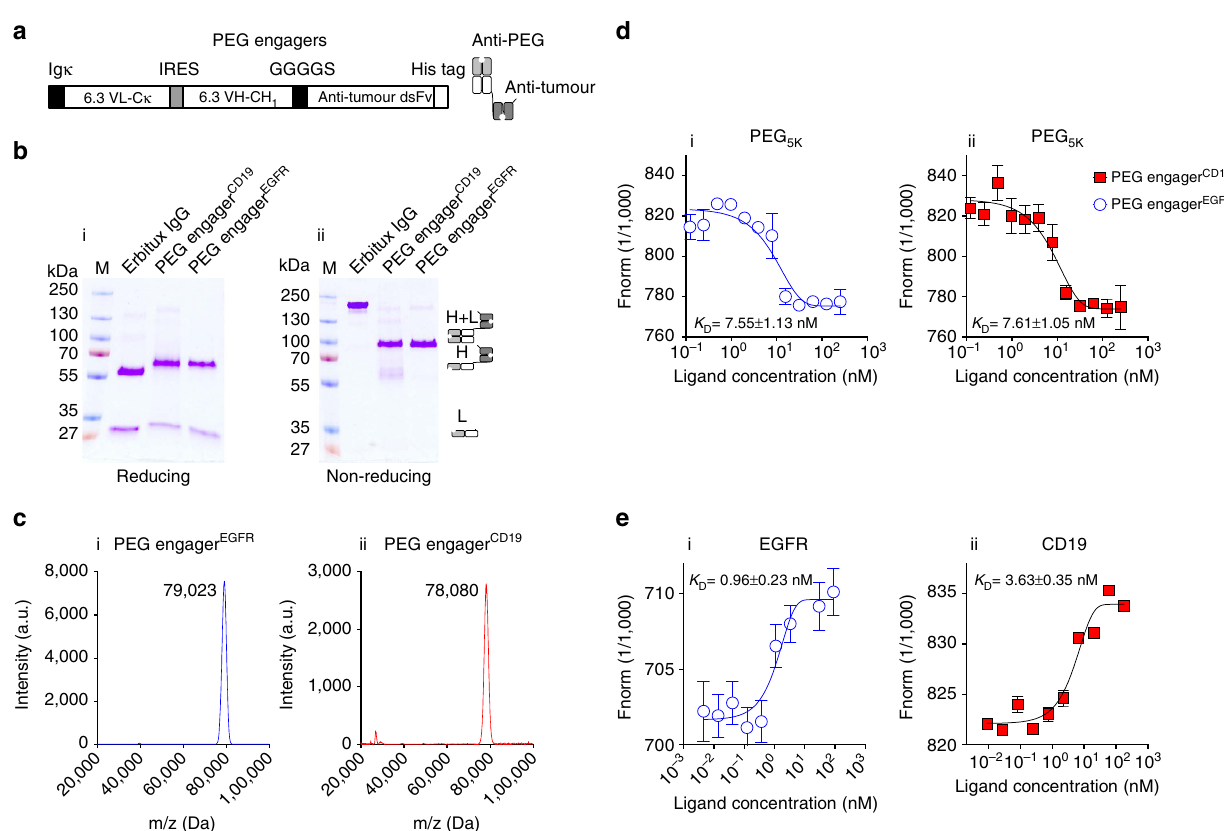
Figure 2 | Production and analysis of recombinant PEG engagers. ( a ) Schematic representation of PEG engager constructs, which code for a murine immunoglobulin kappa chain leader sequence (Ig k ), a humanized 6.3 light chain (6.3 VL–C k ), an internal ribosome entry site (IRES) sequence, a humanized 6.3 heavy chain fragment (6.3 VH–CH 1 ), a glycine-serine peptide linker (GGGGS), an antitumour single chain disulfide-stabilized variable fragments (dsFv, anti-CD19 or anti-EGFR), and a polyhistidine-tag (His tag). ( b ) Reducing (i) and non-reducing (ii) sodium dodecyl sulfate polyacrylamide gel electrophoresis showing Coomassie blue staining of Erbitux, PEG engager EGFR and PEG engager CD19 . M, PageRuler prestained protein ladder (Fermentas). H (heavy chain), L (light chain). ( c ) Precise molecular weight of PEG engager EGFR (i) and PEG engager CD19 (ii) analysed by matrix-assisted laser desorption/ionization time-of-flight mass spectrometry. Mass-to-charge ratio ( m/z ). ( d ) Binding affinity of PEG engager EGFR (i) and PEG engager CD19 (ii) to PEG 5k analysed by microscale thermophoresis ( n ¼ 3). ( e ) Binding affinity of PEG engager EGFR to recombinant EGFR protein (i) and PEG engager CD19 to recombinant CD19 protein (ii) analysed by microscale thermophoresis ( n ¼ 3). Equilibrium dissociation constant ( K D ). Data are shown as mean ± s.d. Representative microscale thermophoresis data from three independent experiments are imaging revealed that the engager remained on the plasma and A431 EGFR-positive epidermoid carcinoma cells. Cancer membrane of MDA-MB-468 (Fig. 4a(i–iii) and Supplementary cell-specific uptake of PEGylated nanoparticles mediated by Fig. 3ai) and BT-20 (Supplementary Fig. 2i–iv) cells at 37 (cid:2) C for PEG engagers was examined by real-time confocal microscopy 1 h with almost no internalization (Alexa Fluor 647 appears in cell imaging of EGFR-negative MCF7 cells or EGFR-positive green pseudo color). PEG engager EGFR displayed limited endo- MDA-MB-468 and A431 cells treated stepwise with PEG engager EGFR or PEG engager CD19 and then fluorescent PEGylated cytosis in MDA-MB-486 cells even after 9 h (Supplementary Fig. 3bi). PEG-Qdot655 added to the cells, however, bound to Qtracker 655 non-targeted quantum dots (PEG-Qdot655). PEG engager EGFR on the cell membrane and were rapidly inter- Both MDA-MB-468 TNBC and A431 cells express EGFR but nalized into the cells (Fig. 4axii–xiv, Supplementary Fig. 2xii–xiv not CD19. MCF7 cells express neither EGFR nor CD19. PEG and Supplementary Fig. 3bvi–viii, red colour). Co-localization of PEG engager EGFR and PEG-Qdot655 or lysosomes (Fig. 4a, Supplementary Figs 2 and 3b) verified that PEG engager EGFR can conditionally stimulate endocytosis of PEGylated nanoparticles and then localize in lysosomes (Fig. 4b,c and Supplementary Fig. 3c). PEGylated nanoparticles into cancer cells that express EGFR.